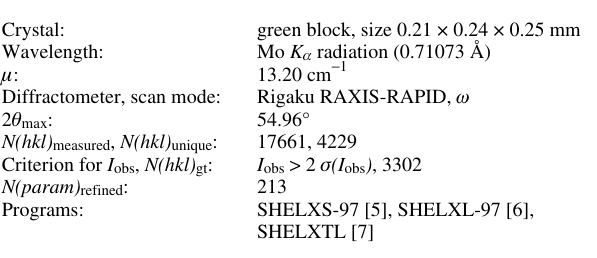
Table 1. Data collection and handling.